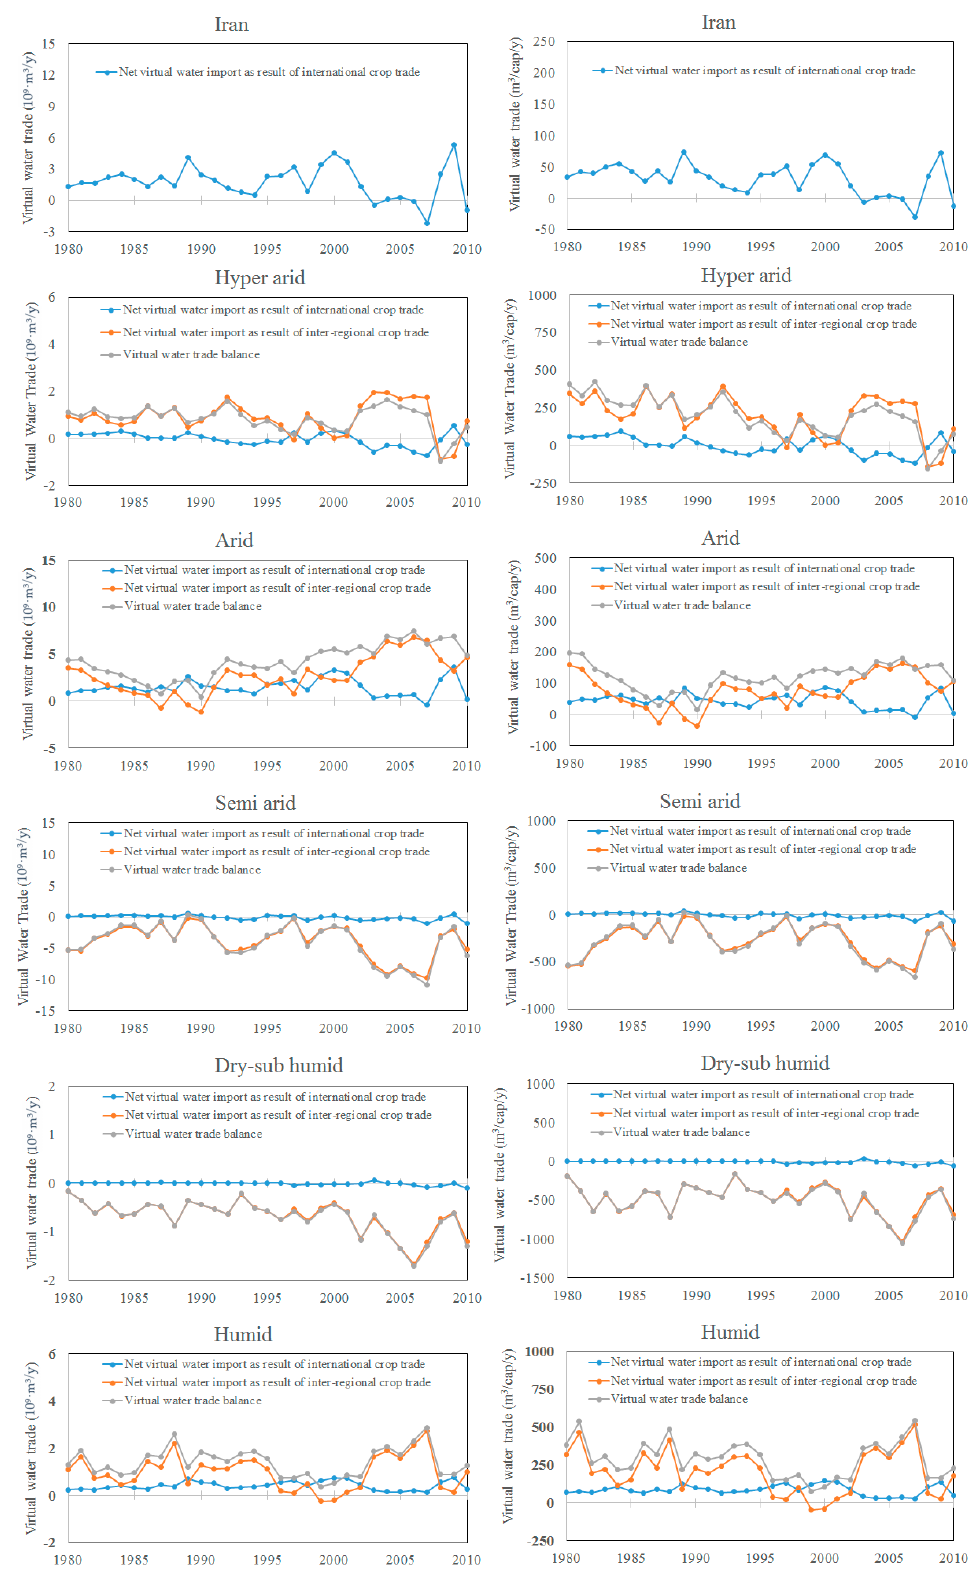
Figure 10. Overall net virtual water trade balance (VWB) and net virtual water import as a result of international and interprovincial crop trade, per climatic region, and for Iran as a whole. Total values in billion m 3 · y − 1 ( left ) and in m 3 · cap − 1 · y − 1 ( right ). Period: 1980–2010.